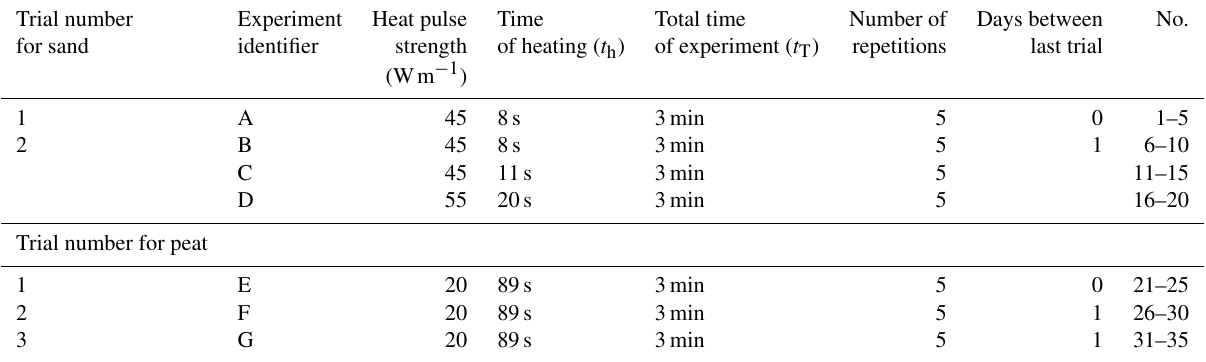
Table 2. Heat pulse strengths, time of heating and cooling, and total time for each experiment conducted on sand and peat. The experiment identifier is an alphabetical letter that identifies the experiment set. “No.” indicates the total number of experiments conducted per set. Trial number Experiment